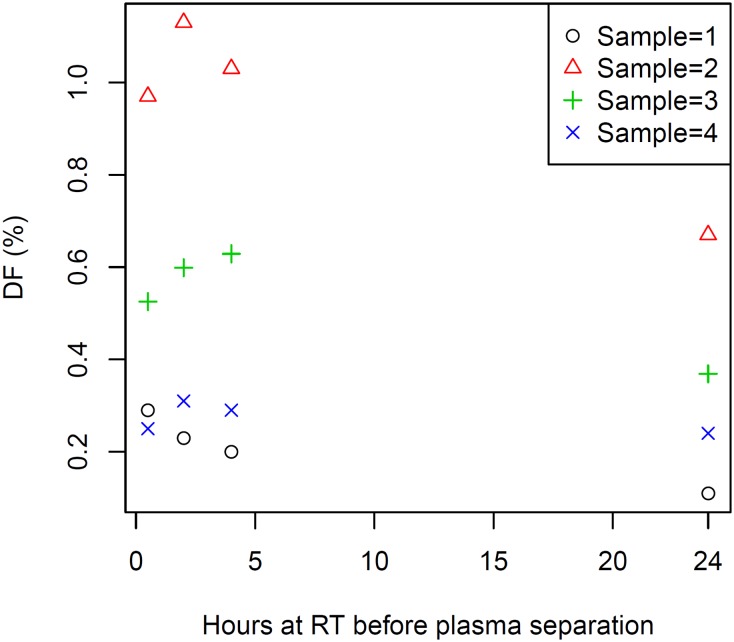
Effect of RT whole blood storage duration (0–24 hr) in Streck BCT tubes on myTAIHEART cfDNA DF.Significant drop in plasma cfDNA DF (0.2% +/-0.05% per day, p<0.01) was observed in four manufactured BCT whole samples (each at a unique starting DF) when plasma separation was delayed by 24 hrs at RT post-phlebotomy. DF is highly sensitive to cfDNA dilution by even very low levels of leukocyte lysis prior to plasma separation. See text for methodological detail.